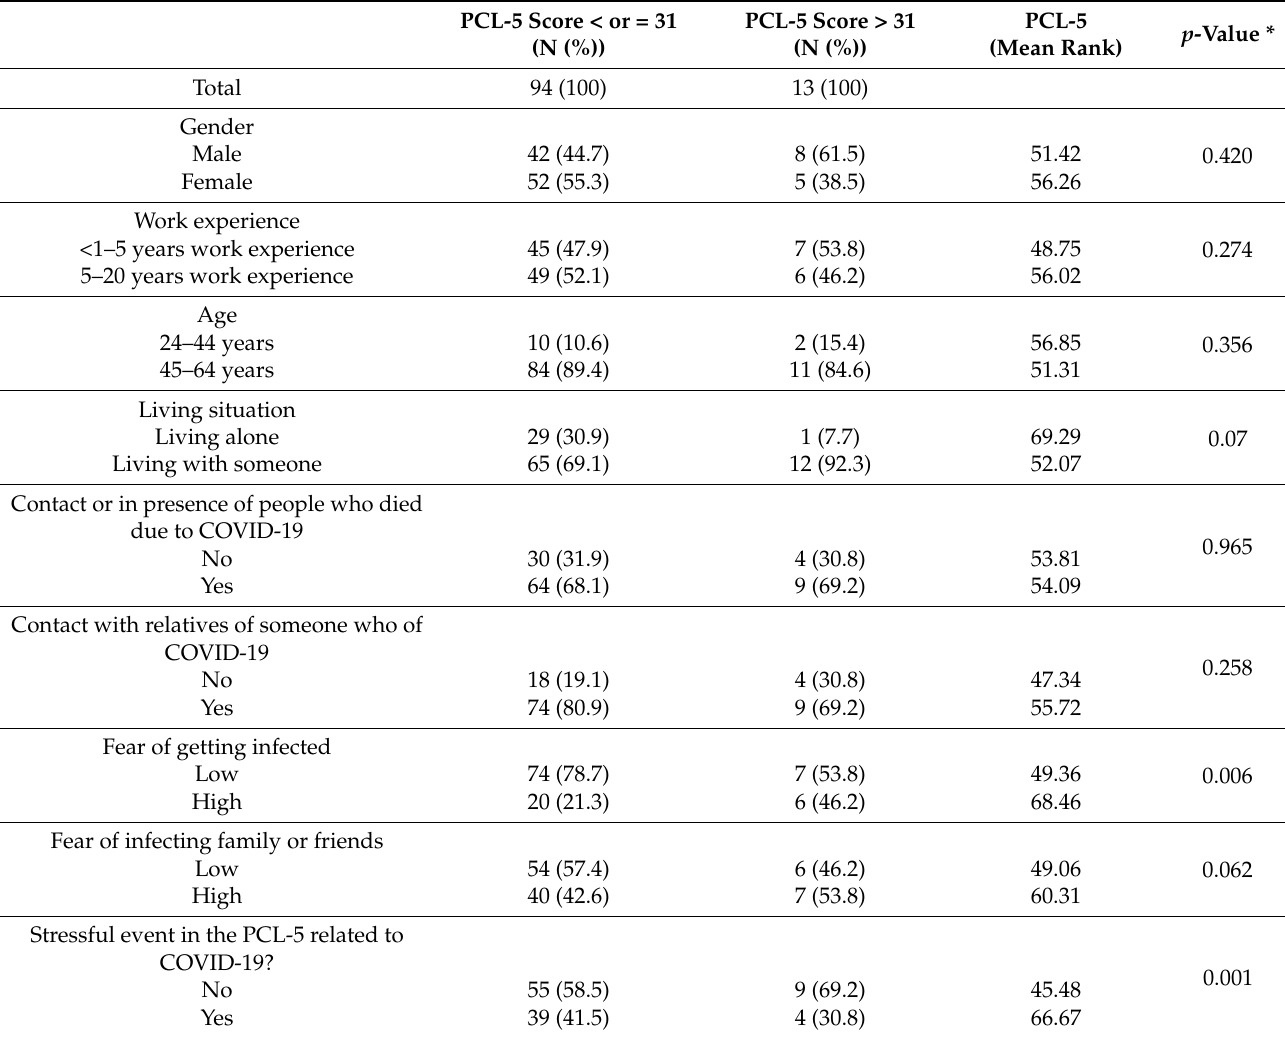
Table 2. Associations between PCL-5 and